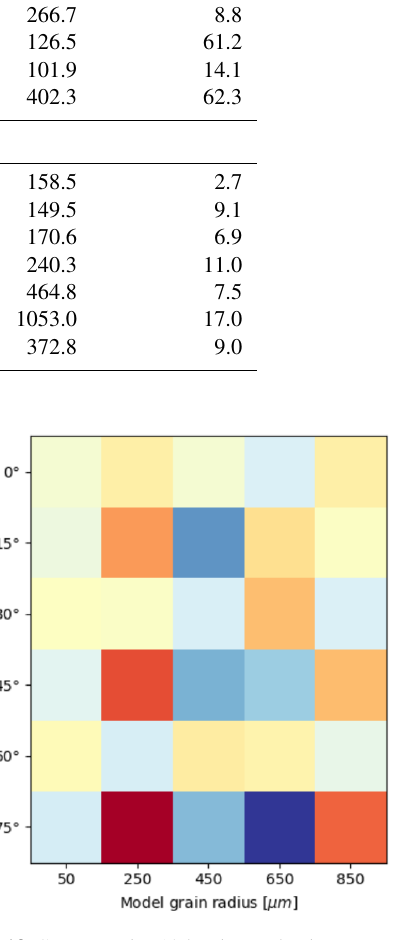
Figure 13. Same as Fig. 12 but instead using BRF as input for both the calibration curve and the